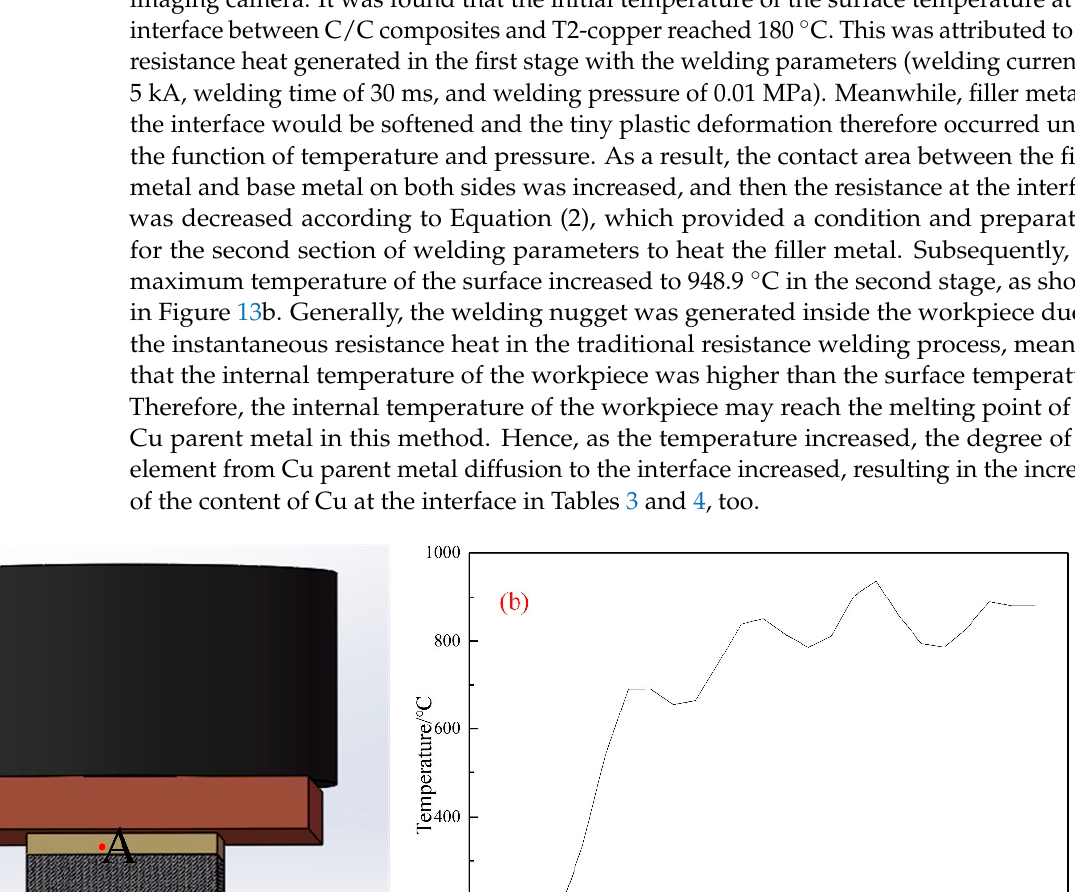
Figure 13. The temperature measurement at the interface of the joint. ( a ) schematic diagram of equipment, ( b ) temperature variation curve of point A at the interface.